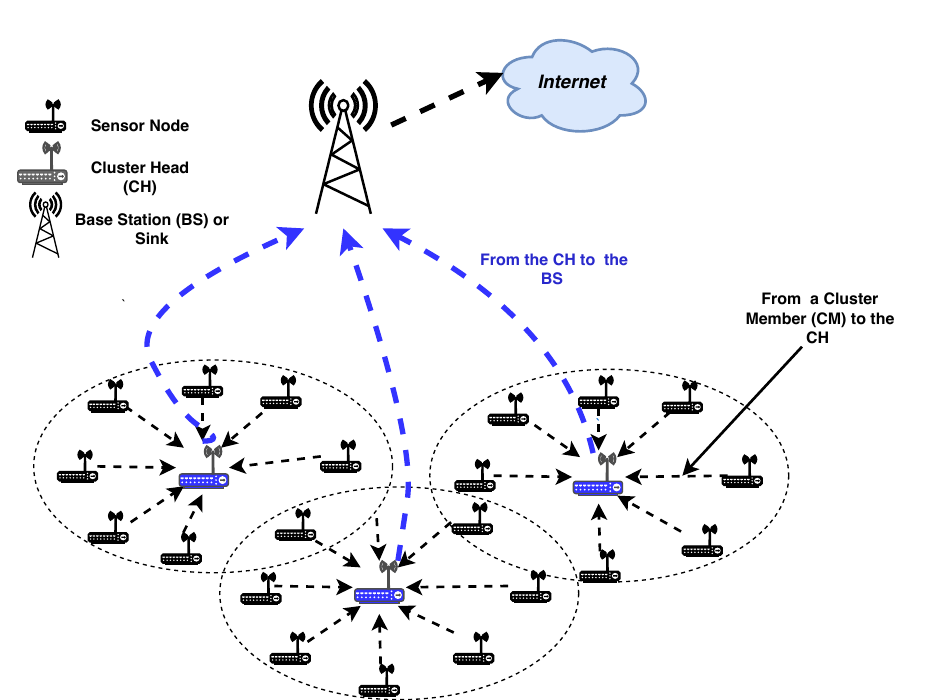
Figure 1. Example of a WSN composed of a number of